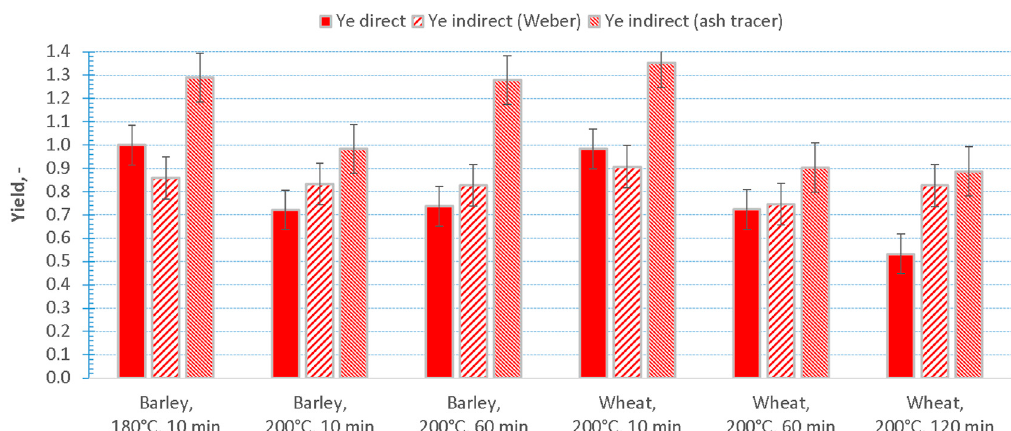
Figure 9. Comparison of energy yield, determined for hydrothermal carbonization experiments, by direct and indirect method.